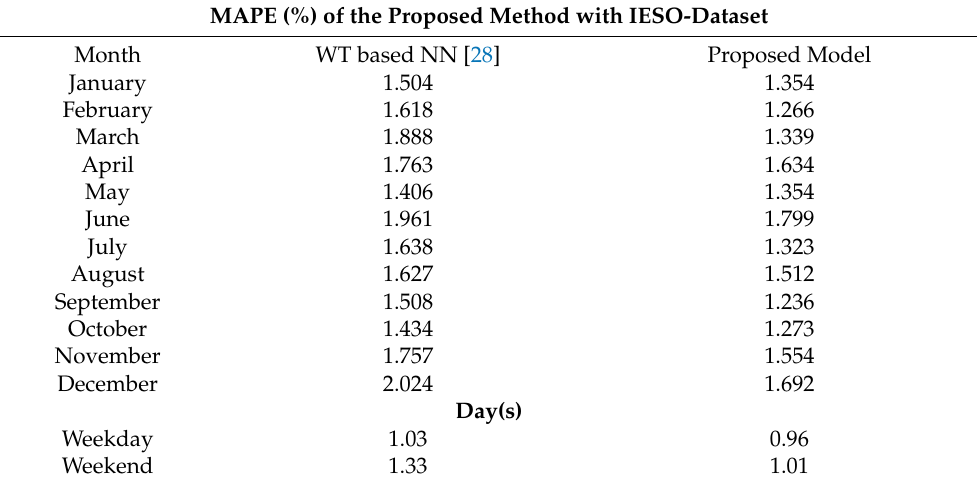
Table 5. MAPEs of the proposed model with the IESO-Canada dataset. MAPE (%) of the Proposed Method with IESO-Dataset